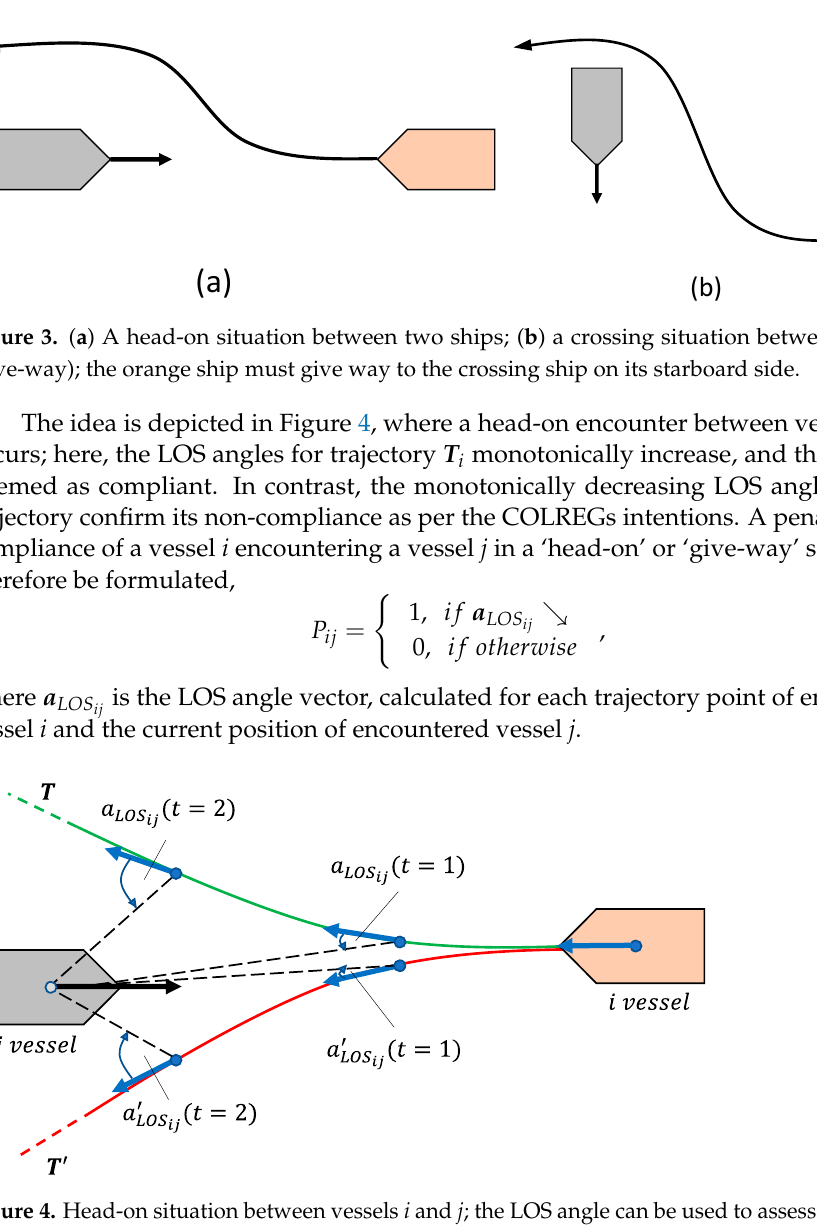
Figure 4. Head-on situation between vessels i and j ; the LOS angle can be used to assess the COLREG compliance of a candidate